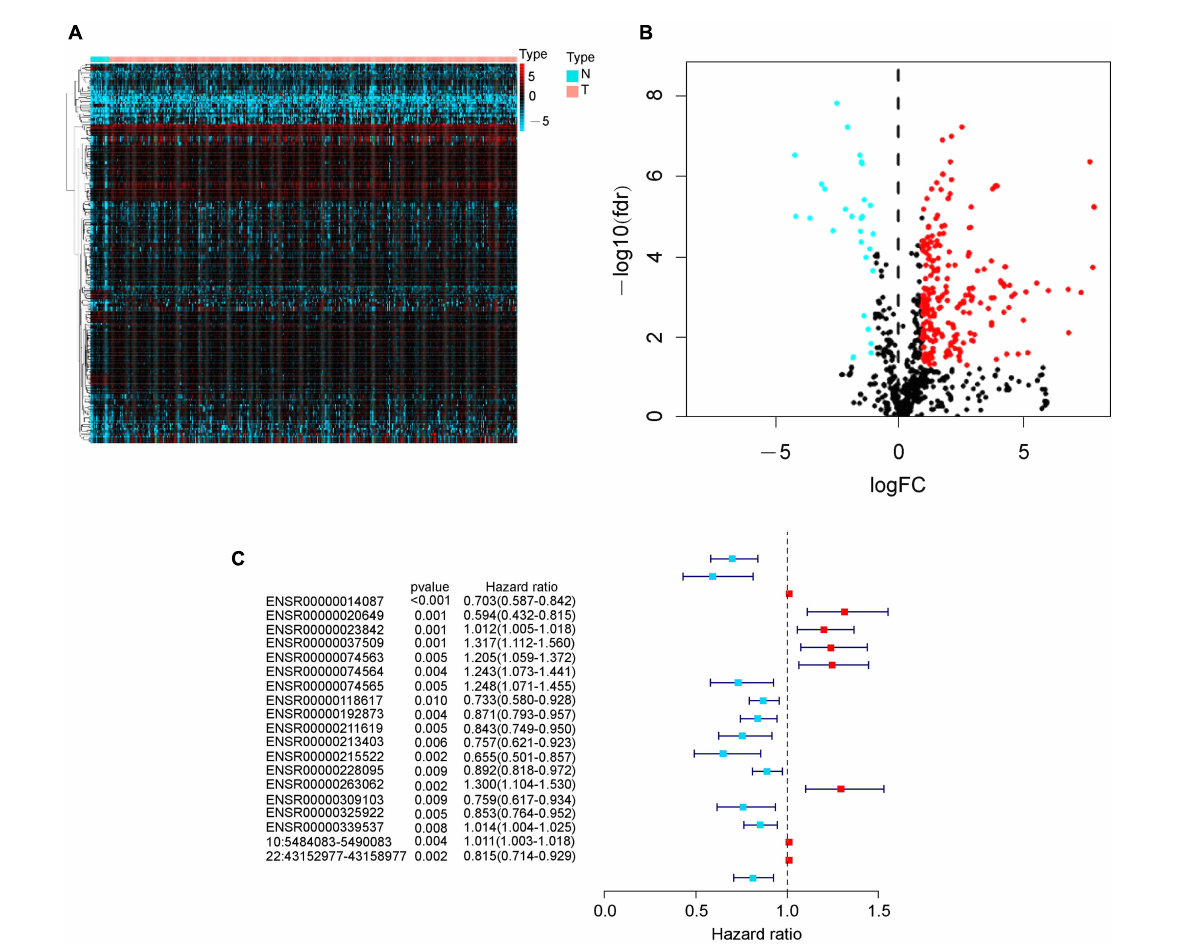
FIGURE1 Identification of differently expressed eRNAs in bladder cancer. (A) Heat map of eRNAs. The blue to red spectrum represents the expression level of eRNA from low to high. (B) Volcano plot of eRNAs. The blue and red dots show downregulated and upregulated eRNA genes, and the black dots indicate unchanged eRNA genes. (C) Forest graph of survival-associated eRNAs. The red and blue dots represent eRNAs with hazard ratio > 1 and ≤ 1, respectively.